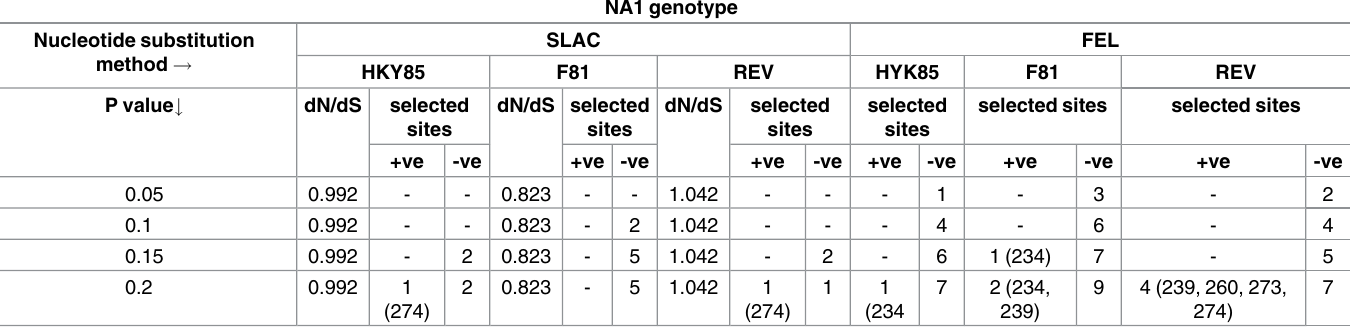
Table 3. Selection pressure analysis of the RSV NA1 genotype of the second hypervariable region of G protein gene using SLAC and FEL